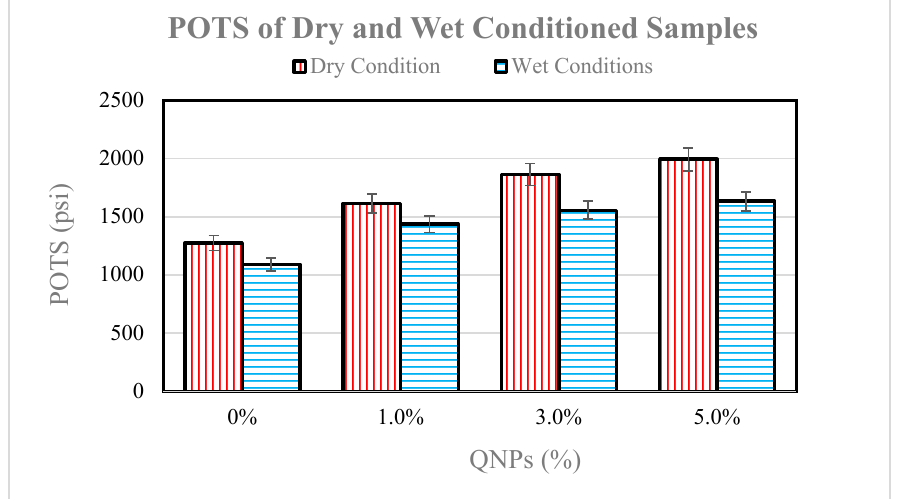
Figure 17. Graphical representation of POTS (psi). Table 8. Average POTS (psi) values of base and QNP ‐ modified bitumen and failure patterns.